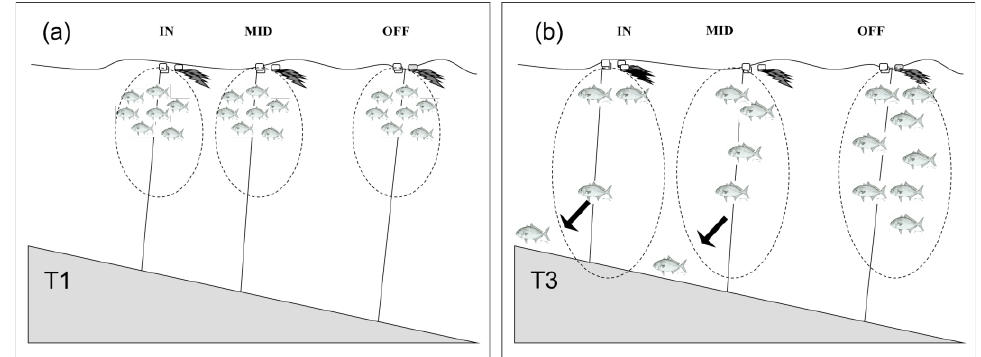
Figure 4. Redrawn from [18]. Possible explanation of the observed pattern for Bailistes capriscus , Seriola dumerili , and Thachurus thracurus , ( a ) At an earlier stage (T1) small-sized YOYs have a small ERI (dotted circle), which constrains them to the immediate vicinity of FADs. ( b ) Later, when fish grow (T3 ), ERI also increases and fish associated to IN and MID FADs may have a greater possibility of encountering a more suitable habitat while at OFF FADs, where ERI is smaller than the distance from the bottom, fish may thus remain associated longer and unnaturally to